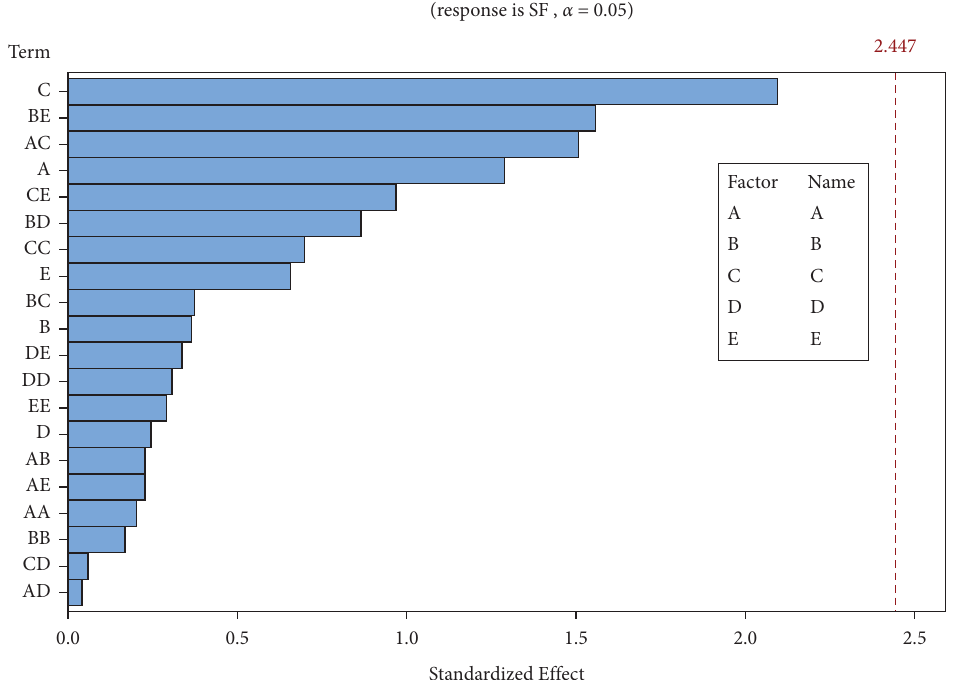
Figure 14: Sensitivity plot of design variables to the safety factor.